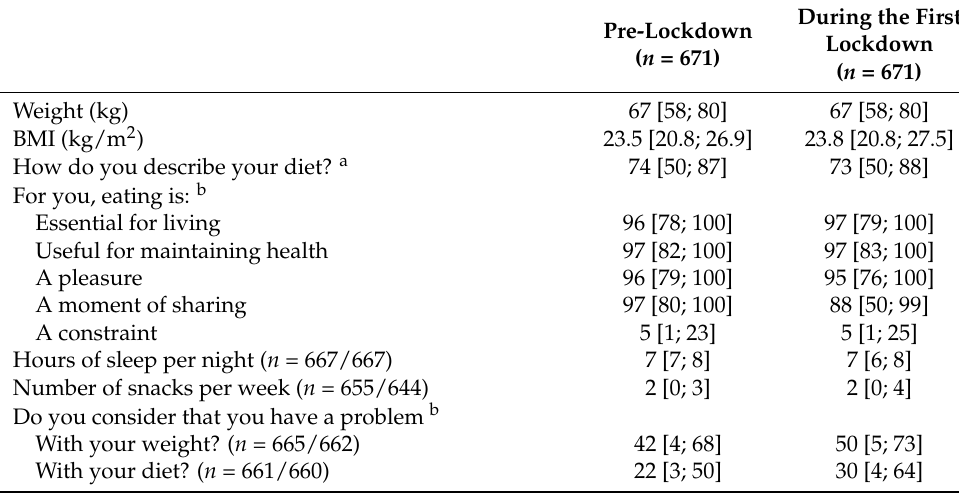
Table 2. Eating and behavior data of the population before and during the first